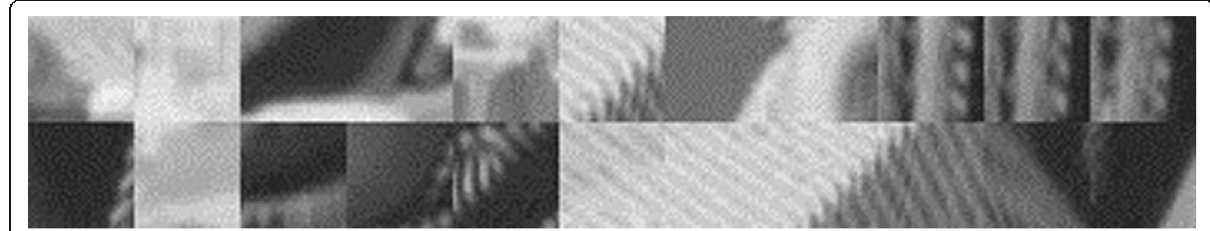
Fig. 3 The selected image quality patches in